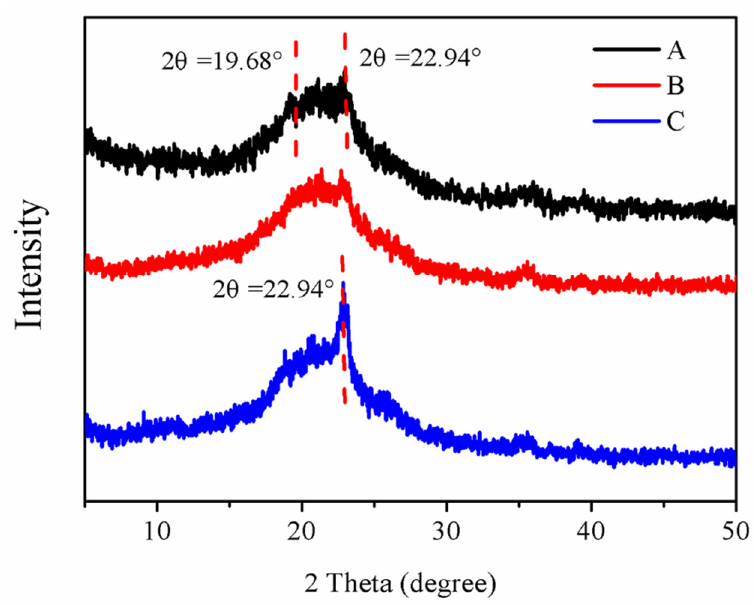
Figure 5. XRD spectra of PF108 powder ( A ), PF108 hydrogels ( B ), and QEO nanohydrogels ( C ).